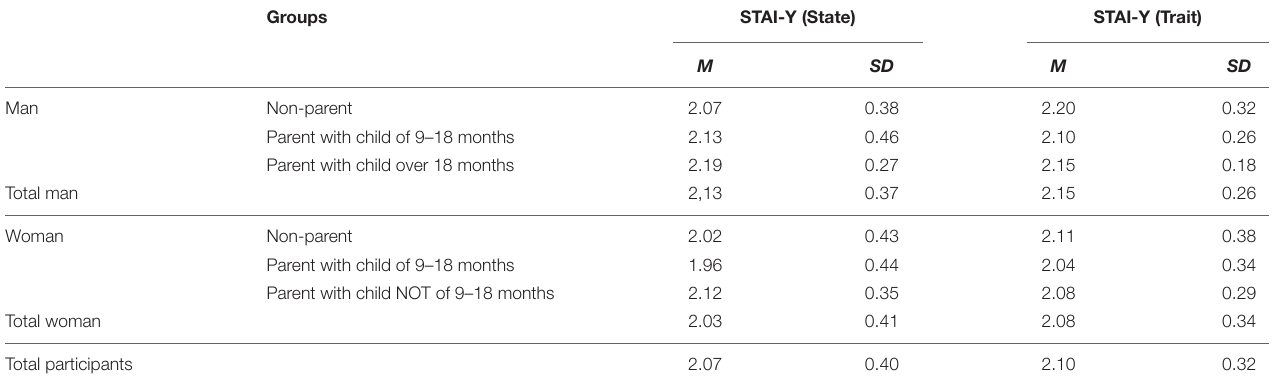
TABLE 3 | Means and standard deviation of STAI-Y State and